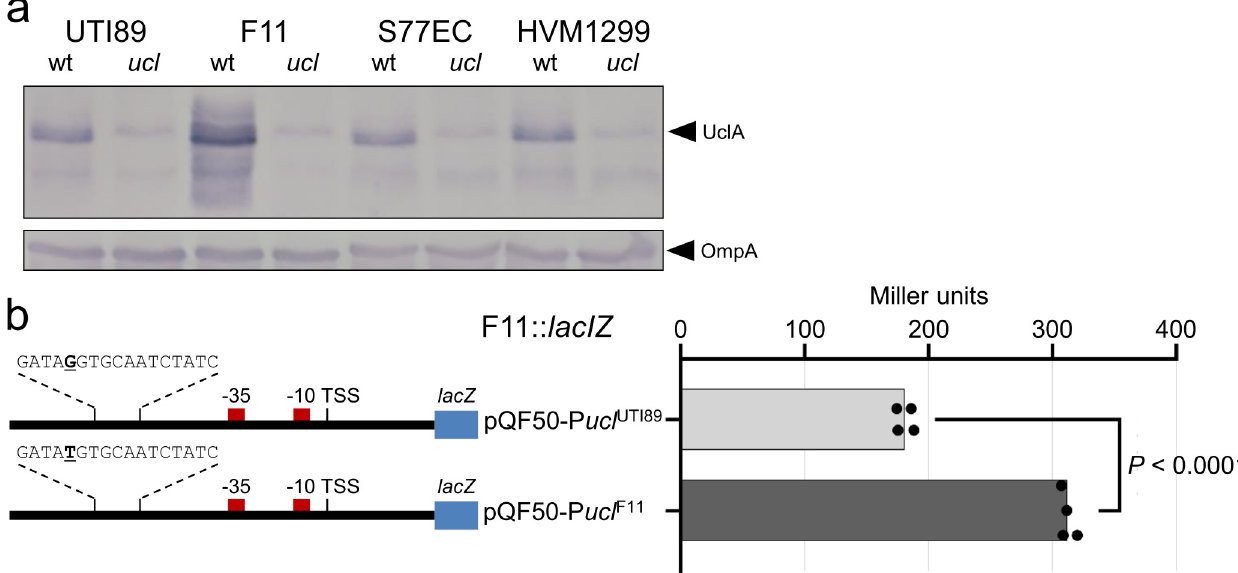
Fig 1. Expression of UclA differs among ExPEC strains. a) Whole-cell lysate western blot analysis of UTI89, F11, S77EC and HVM1299 and their respective ucl deletion mutants, using a polyclonal antibody generated against UclA F11 (18.9 kDa) and OmpA (loading control). b) Left, schematic diagram of the ucl promoter region from F11 and UTI89 cloned in the reporter plasmid pQF50. Indicated are the TSS, -10 and -35 promoter elements, and OxyR binding site. Right, β -galactosidase activity (measured in Miller units) for the pQF50-P ucl F11 -lacZ versus pQF50-P ucl UTI89 -lacZ fusion constructs in F11 lacZ (p < 0.0001; one-way ANOVA with Sidak’s multiple comparisons